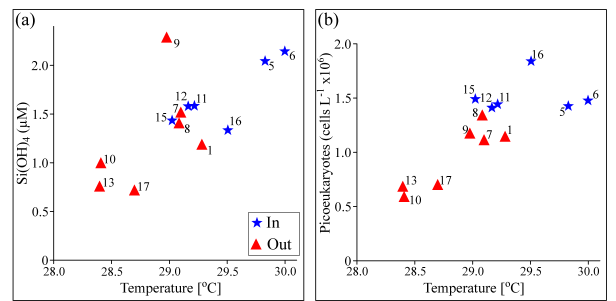
Fig. 6. (a) Black boxes mark the locations of regions of interest (ROIs) along the patch’s main axes, used for extracting the time se- ries in panel (b) . The ROIs are superimposed on a satellite-derived chlorophyll map showing the patch’s extension. (b) Temporal evo- lution of surface chlorophyll concentrations at the 4 regions of in- terest along the patch’s main axis.